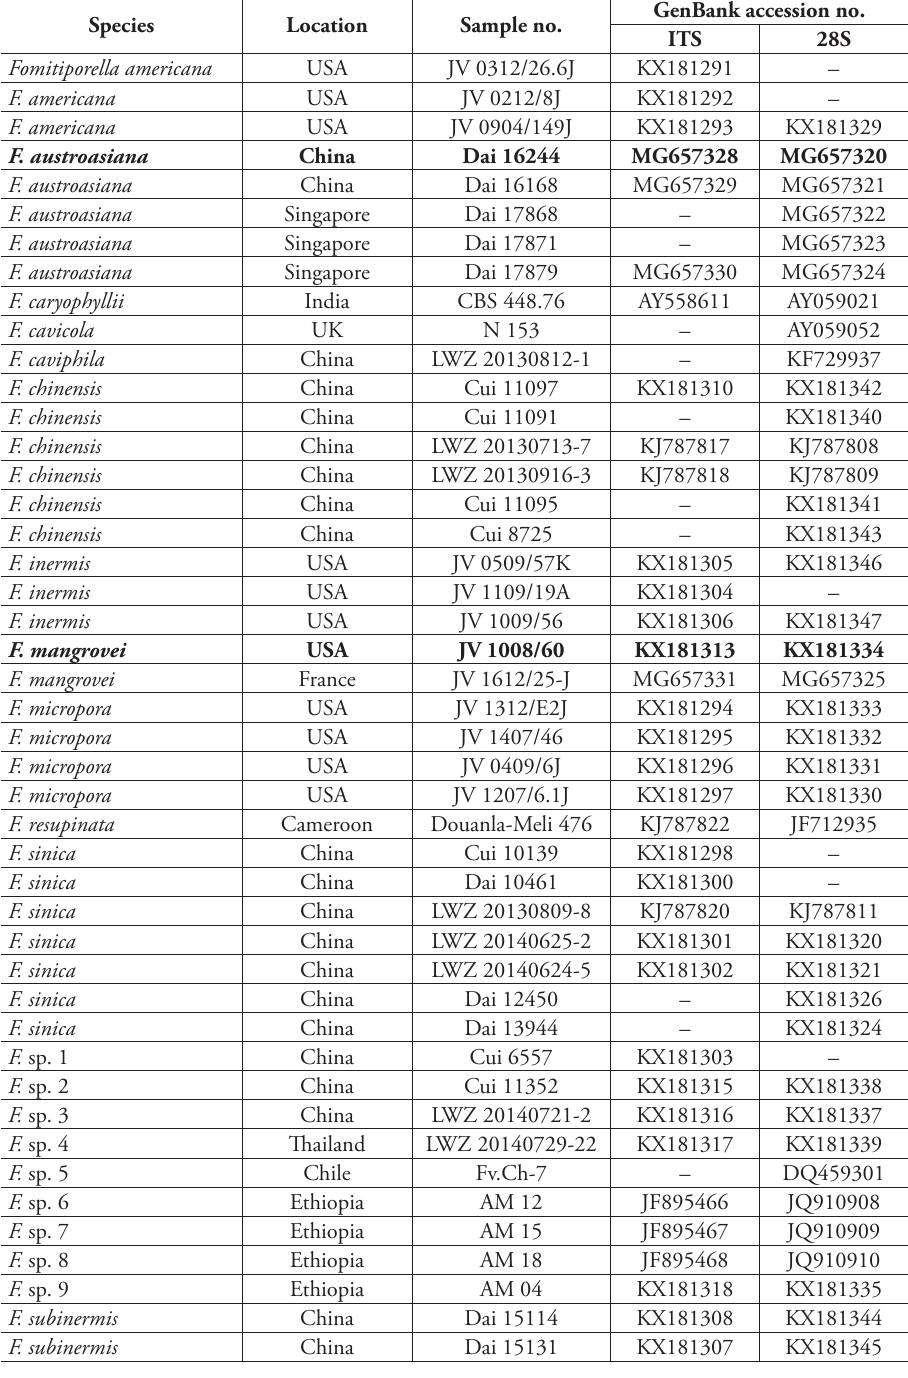
Table 1. Information on the sequences used in this study. Type specimens are shown in bold. Species